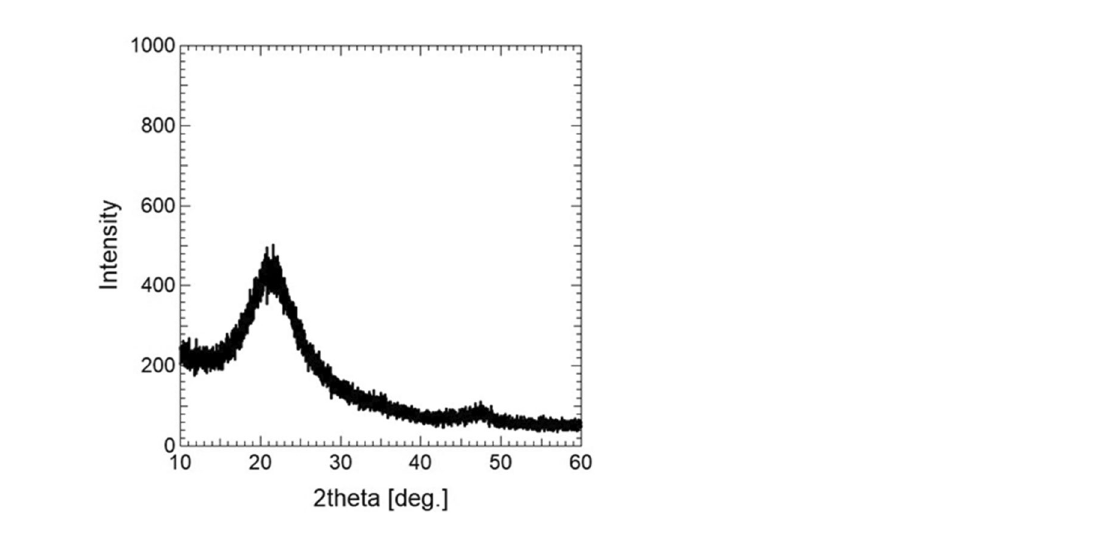
Figure 7. XRD pattern of ALD Al 2 O 3 thin